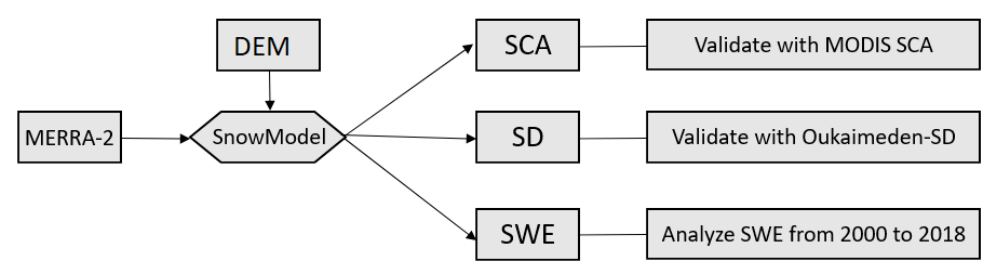
Figure 4. Summary of the methodology. SCA, snow cover area; SD, snow depth; SWE, snow water equivalent.